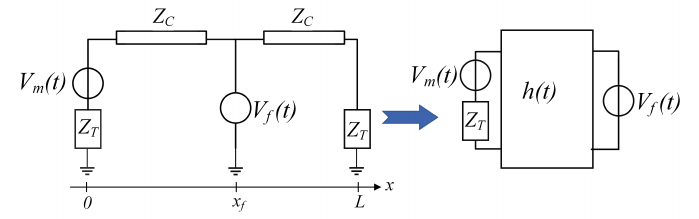
Figure 1. Simplified representation of post-fault line. (I) Forward propagation stage: In this stage, fault-generated transient signals are measured at one of the line extremities, such as V m ( t ) at x = 0 in Figure 1. (II) Back- propagation stage: The measured transients in Step 1 are time-reversed and back-injected into the simulated system model from the same observation point, e.g., V m ( T − t ). Then, on each pre-defined GFL ( x g ), the fault signals are observed. (III) Finally, the fault location is computed by employing different proposed